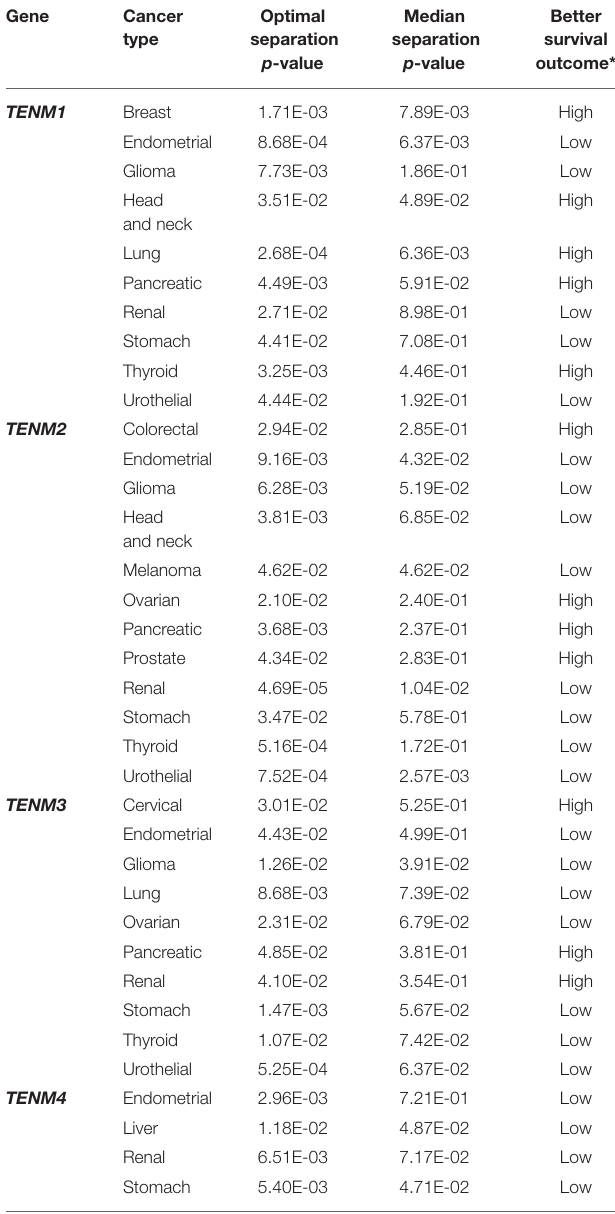
TABLE 2 | Significant associations between Teneurin transcript levels and patient